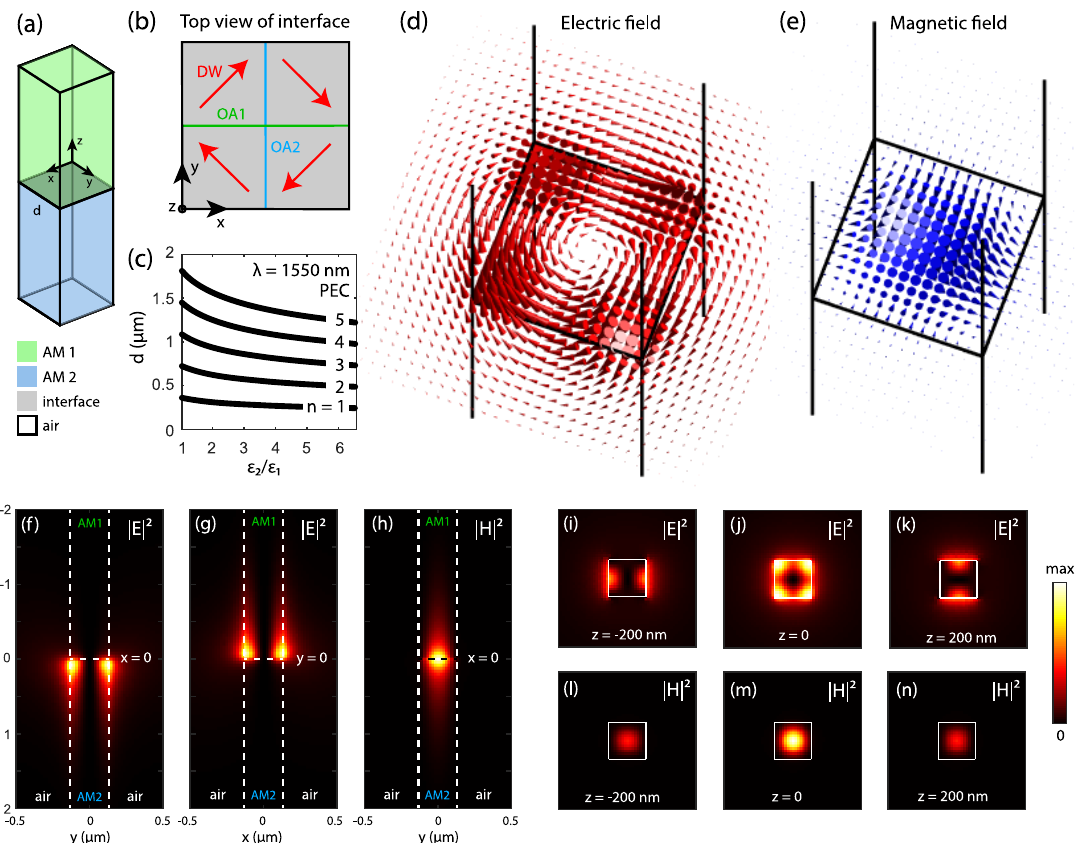
Figure 5: (a) The interface between two square cylinders made of anisotropic materials (AM). (b) The orientation of optical axes is shown by blue and green lines. Dyakonov waves reflect from the air boundaries at the angle of α (cid:1) 45 ∘ forming a two-dimensionally con fi ned mode. (c)Theanisotropyfactordependenceofsquarewidths d atwhichtheDSCMexistfordifferentmodeorders n .(d)Electricand(e)magnetic fi elds calculatedinthe horizontalplane z (cid:1) 0 in DSCM.Blacklinesdenote the edgesof rods.Electric(f,g, i – k) and magnetic(h, l – n) fi eldintensities inDSCMinhorizontal(i – n)andvertical(f – h)cross-sections. d (cid:1) 264 . 34 nm, ε 1 (cid:1) 9, ε 2 (cid:1) 36, λ (cid:1) 1550 nm.DSCM,Dyakonov-like surfacecavity